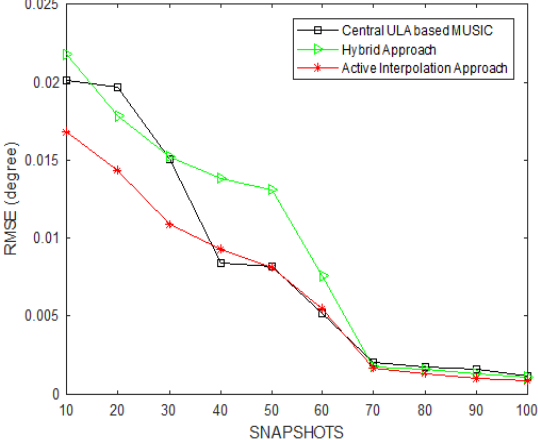
Figure 5. RMSE versus number of snapshots (SNR = 0 dB, K = 16 sources, I = 300